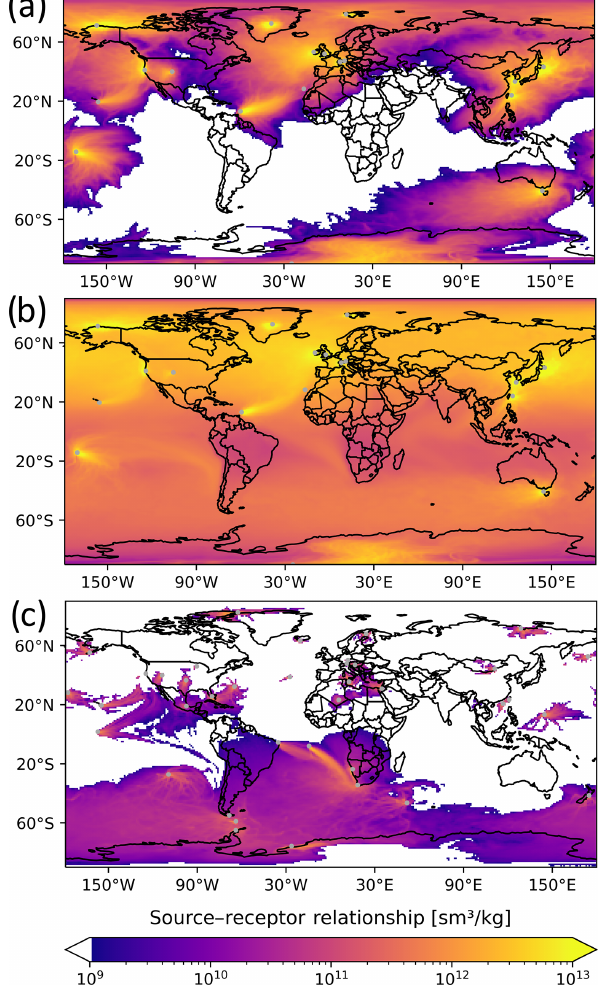
Figure 2. Source–receptor relationship obtained from FLEXPART backward simulations, averaged over the year 2012. The SRR is shown for all considered continuous measurement stations and for a simulation period of (a) 5 and (b) 50d. Panel (c) shows the in- crease in the annual averaged SRR due to the use of flask measure- ments in addition to continuous measurements for the case of a 50d backward simulation